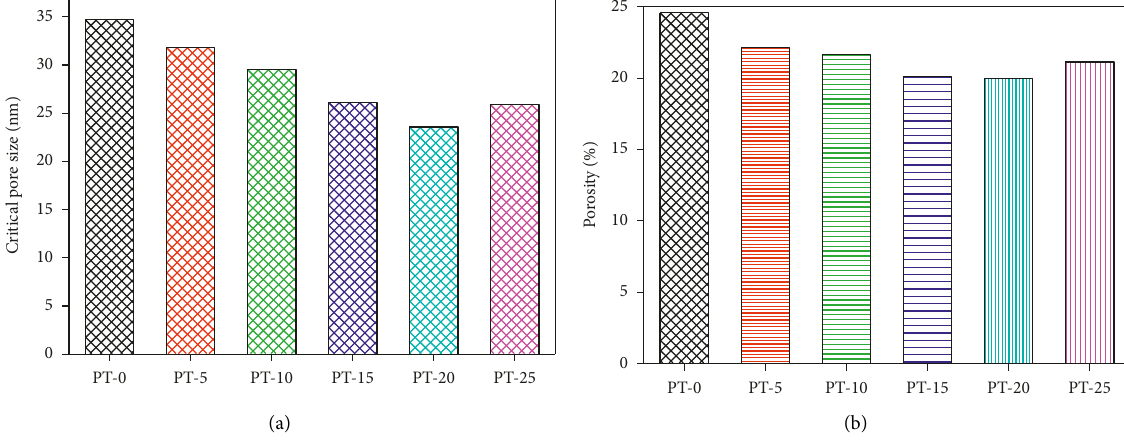
Figure 9: Pore parameters of the coarse aggregate interlocking concrete. (a) Critical pore size. (b)